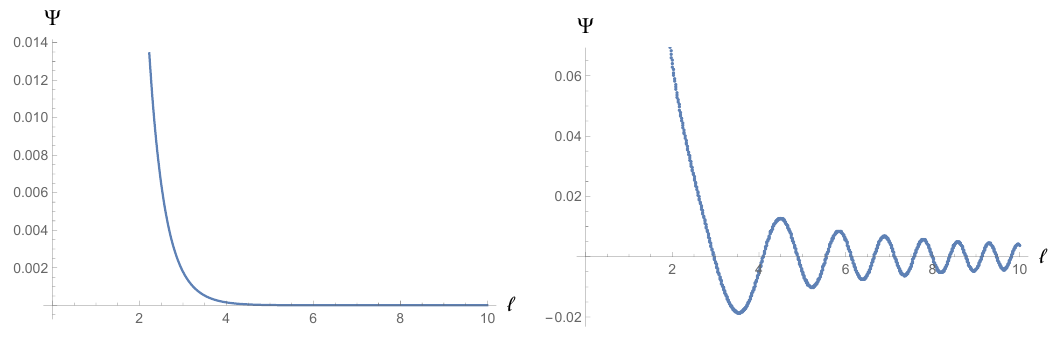
Figure 2 . Left: the genus-zero WdW wavefunction as a function of the size ‘ . Right: the non- perturbative wavefunction (computed numerically) exhibiting a slowly decaying envelope with os-